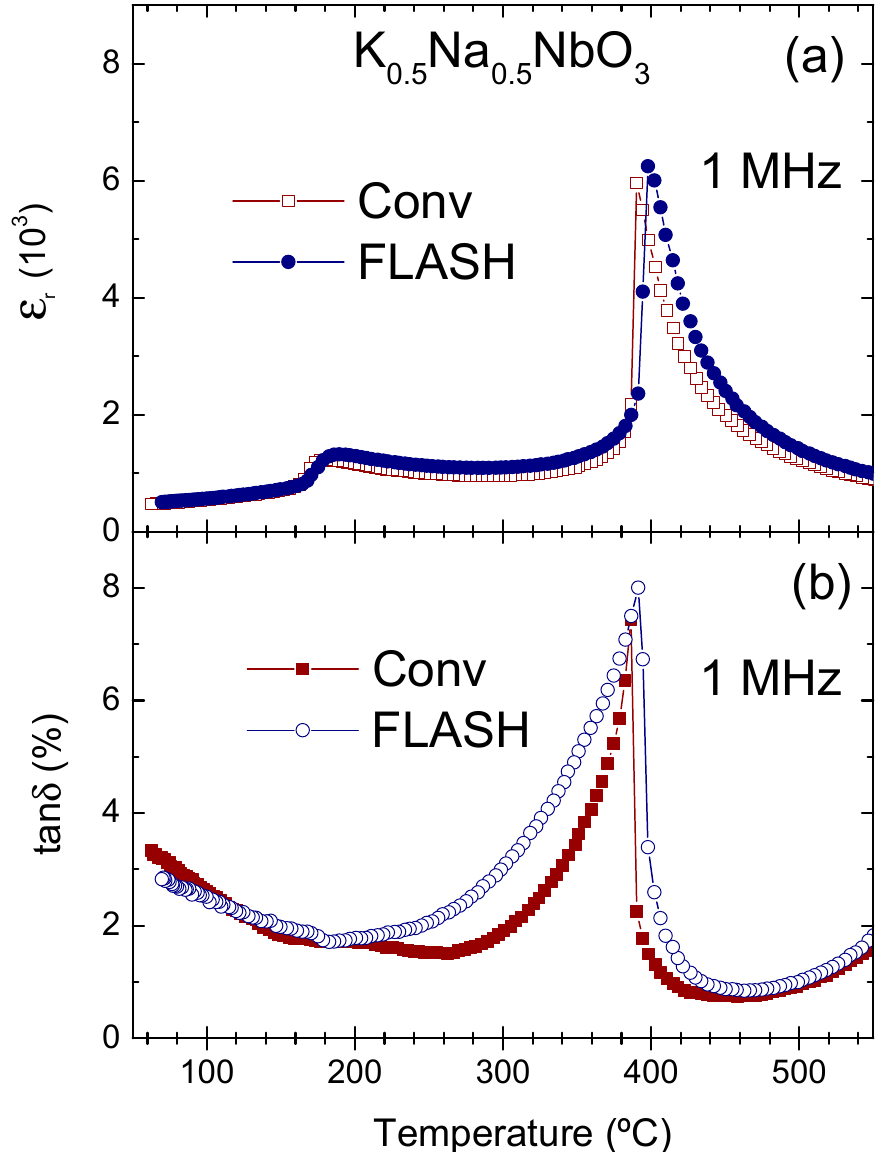
Figure 3. Real part of the relative dielectric permittivity, ε r ( a ), and dissipation factor, tan δ ( b ), of conventionally (squares) and Flash (circles) sintered KNN ceramics measured as a function of temperature, at 1 MHz, on cooling.